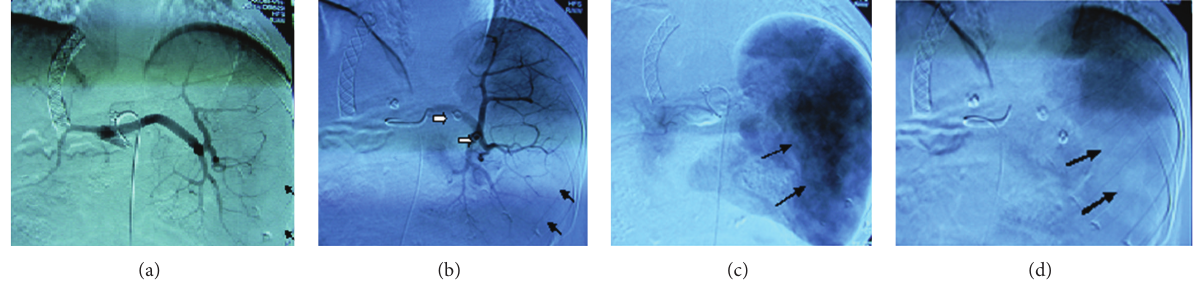
Figure 1: Severe cirrhotic liver has been managed with TIPS for relief of portal hypertension. (a) Angiogram shows the small size of cirrhotic liverandtheenlargedspleenwithabundantperipheralsmallarteries(arrows)beforePSE.(b)Thetrunkandthelowersplenicpolararteryhave been occluded by stainless steel coils (bold arrows). Arterial phase shows fewer peripheral small arteries in the lower part after embolization. (c) Venous phase of the angiogram before PSE shows the lower part with rich venous blood flow (arrows). (d) Compared with the upper part, the lower part after PSE has very poor venous flow